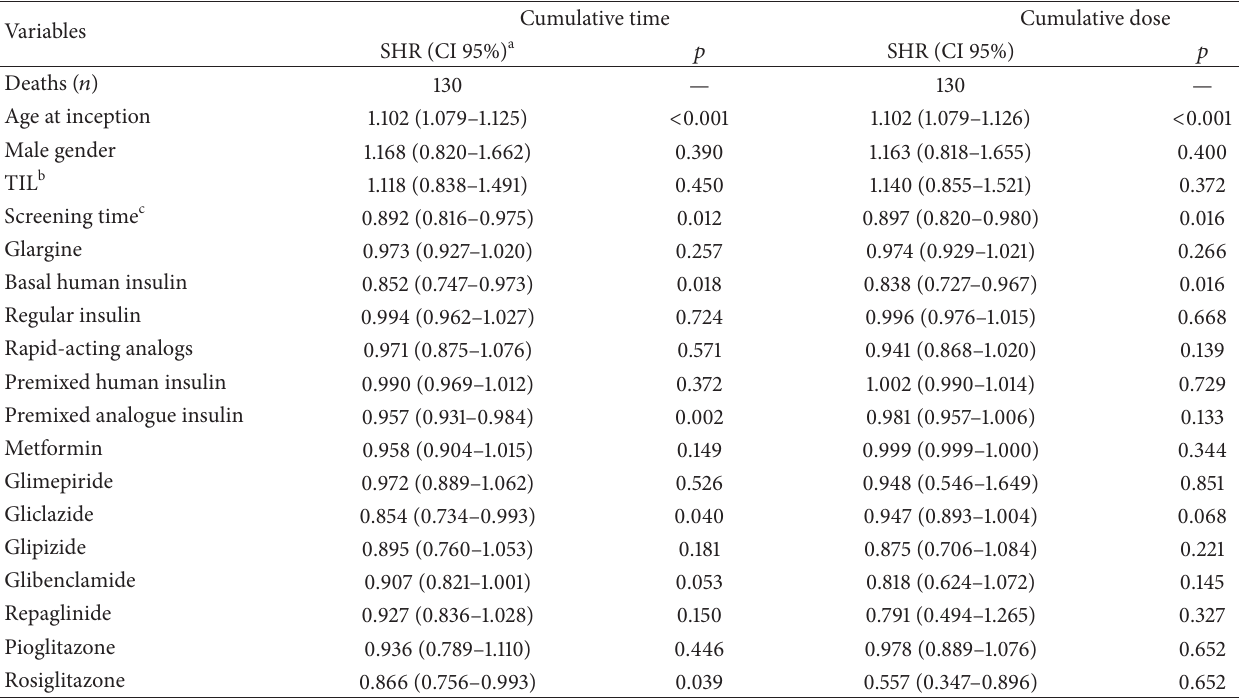
Table 2: Competing risk analysis for stroke